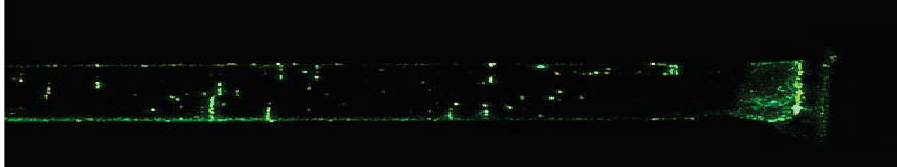
Figure 18. Schematic of the incomplete removal defect.